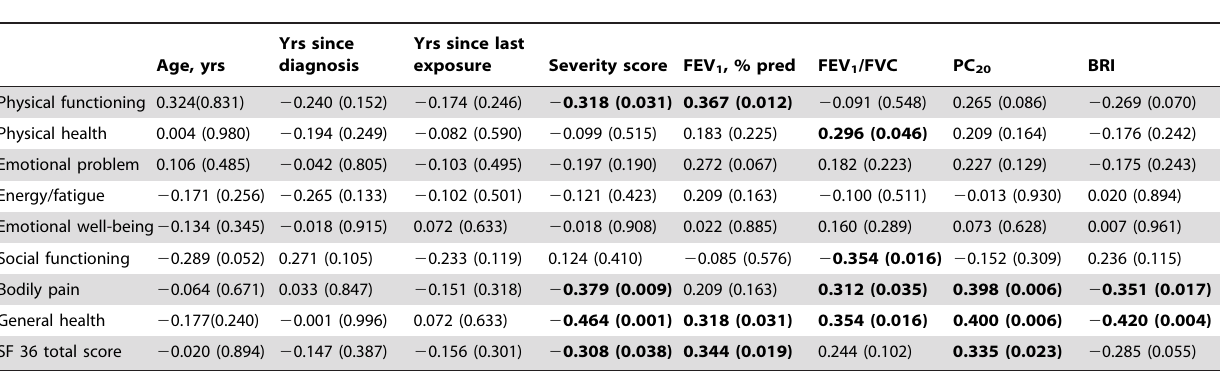
Table 4. Pearson correlation coefficients between SF-36 scores and clinical and spirometric parameters [r (P value)].